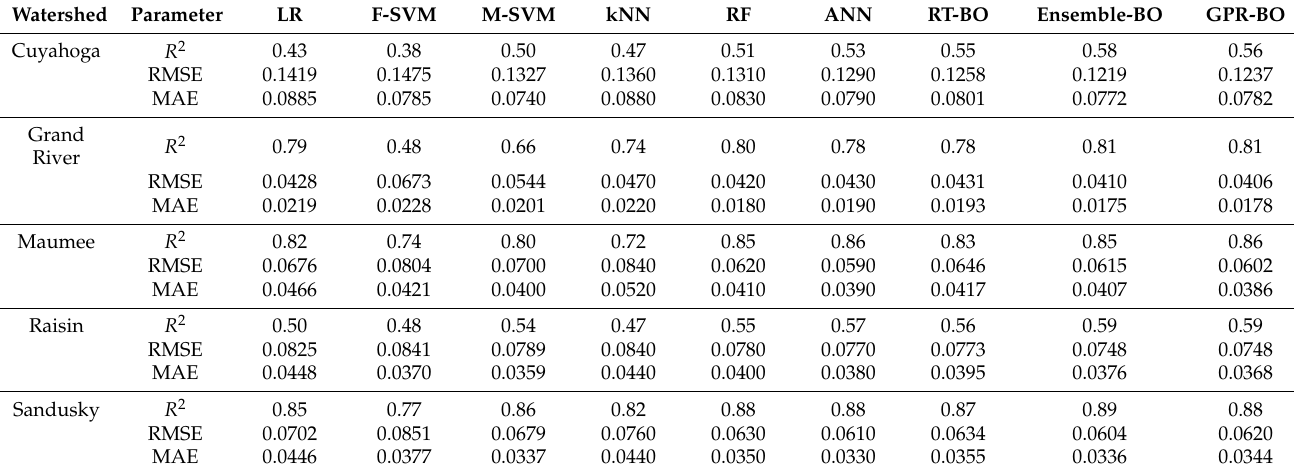
Table 5. Comparison of R 2 , RMSE, and MAE using different ML algorithms for phosphorus prediction on training dataset. Watershed Parameter